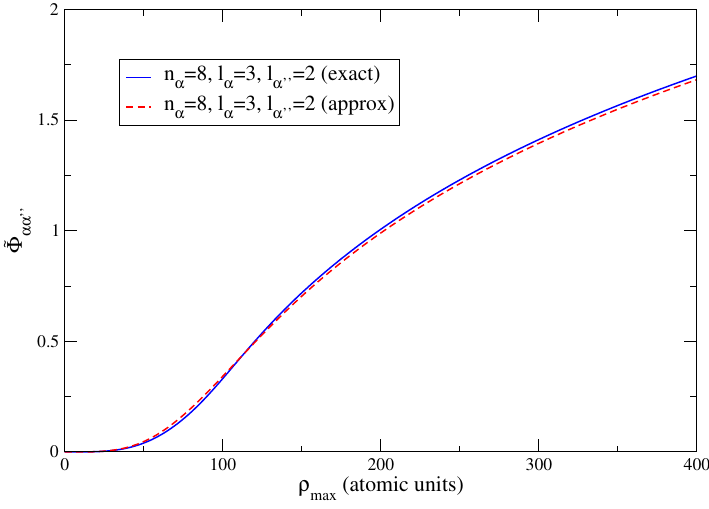
Figure 2. Comparison between the exact computation of the quantity ˜ Φ αα (cid:48)(cid:48) entering the diagonal part of the collision operator (see Equation (36)) and the approximate expression (37) for n α = 8, (cid:96) α = 3, and (cid:96) α (cid:48)(cid:48) =